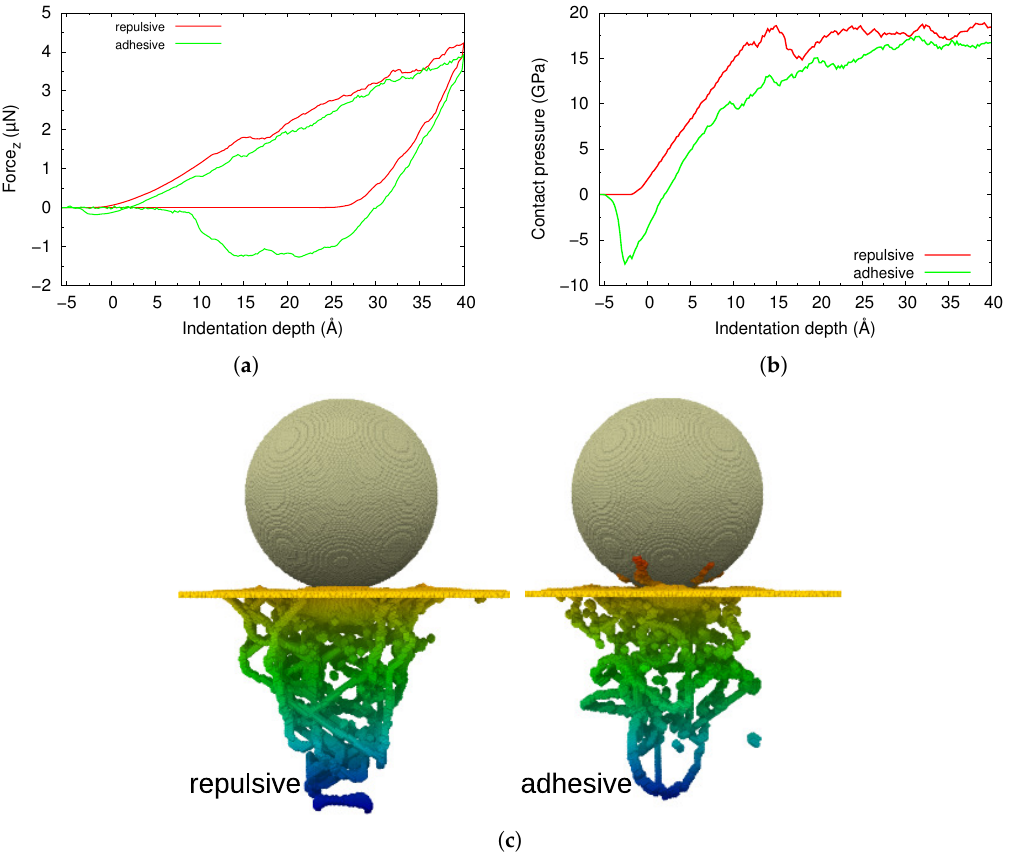
Figure 5. Comparison of indentation with a repulsive and an attractive diamond indenter into a Fe (100) surface. ( a ) Load-depth curve. ( b ) Contact pressure. ( c ) Pile-up after retraction of the indenter. Original contribution of the